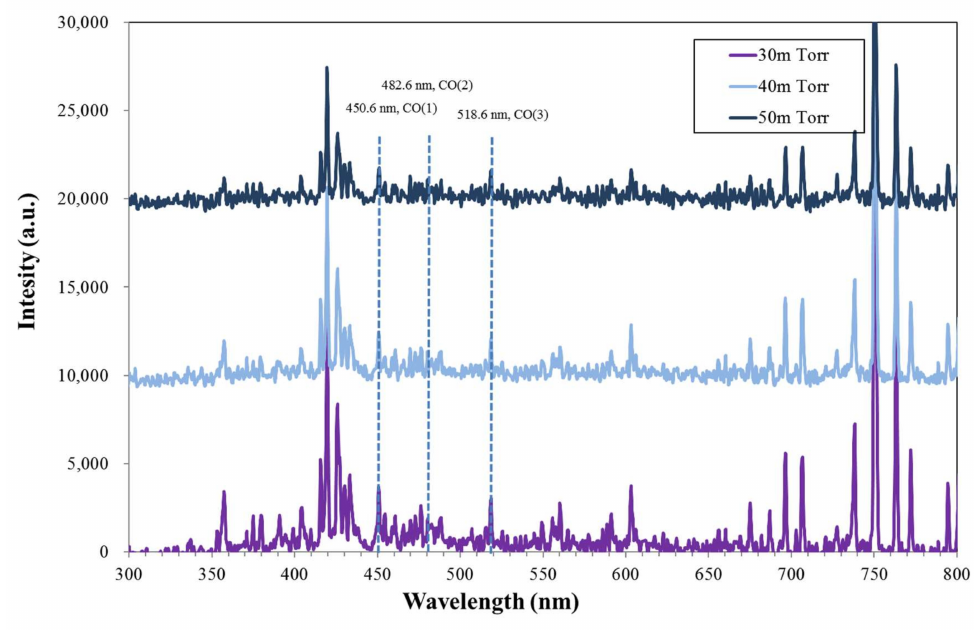
Figure 9. OES spectra of plasma for various working